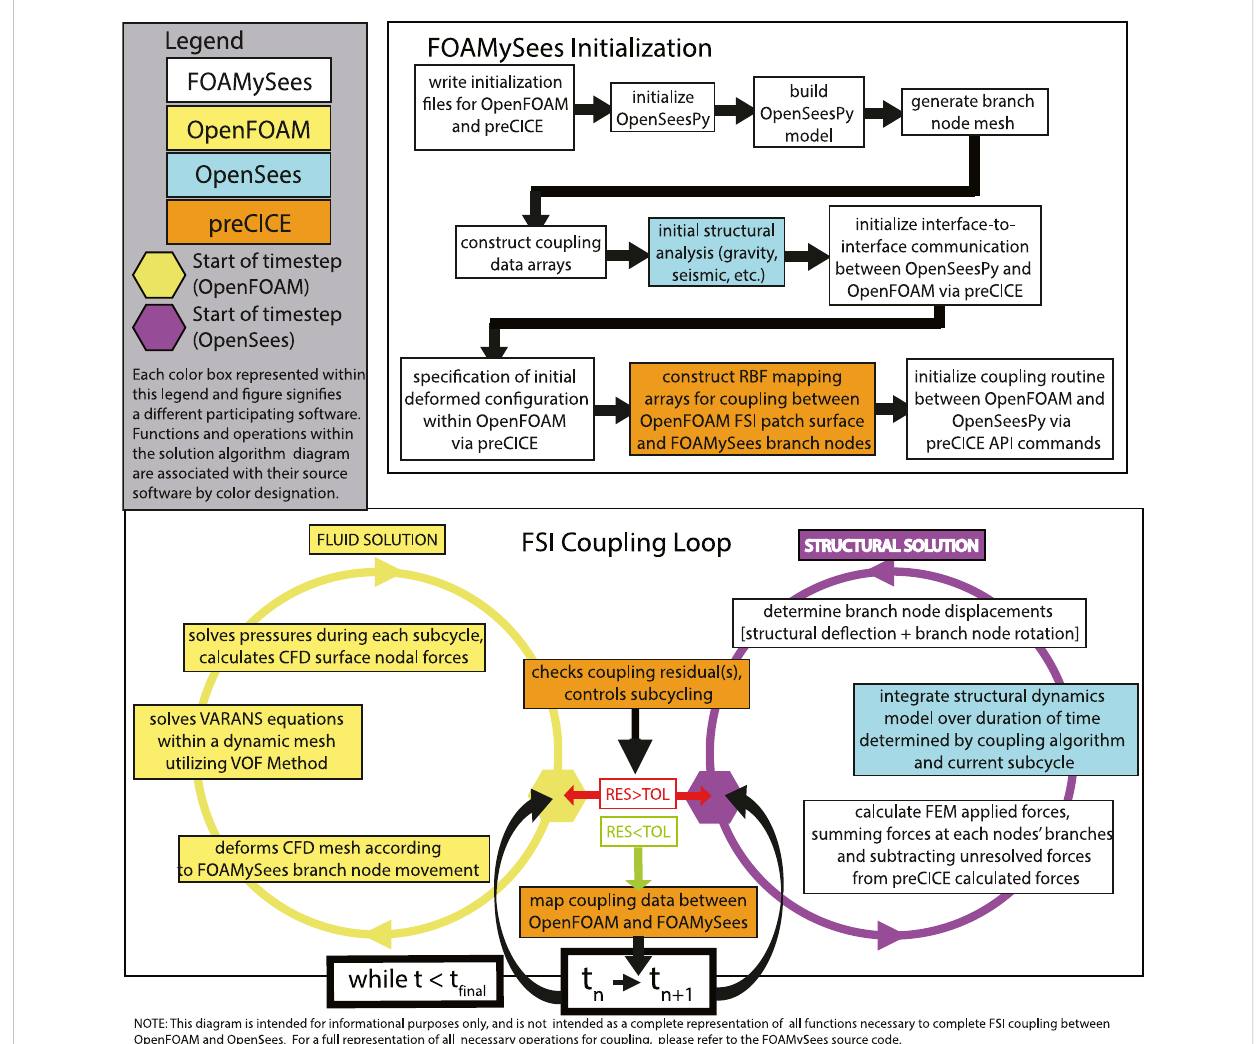
Coupling procedure for FOAMySees